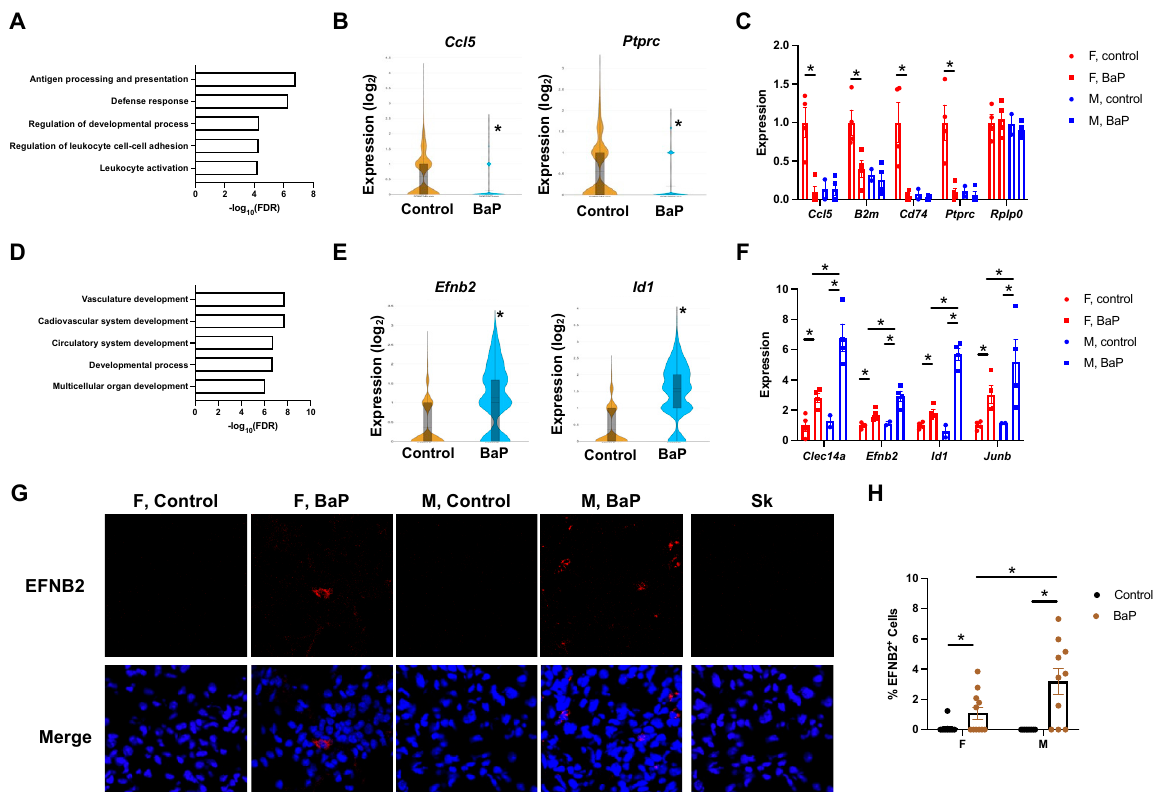
Figure 4. BaP treatment stimulated the expression of vasculature genes in the MRL lung in a male-biased manner. ( A ) Top gene ontology categories enriched in genes downregulated by BaP treatment in female MRL lungs, with example genes shown in ( B ). ( C ) Validation of BaP-downregulated, immune-associated genes by qPCR. ( D ) Top gene ontology categories enriched in genes upregulated by BaP treatment in female MRL lungs, with example genes shown in ( E ). ( F ) Validation of BaP-upregulated, pro-angiogenesis genes by qPCR. ( G ) Immunostaining of EFNB2 in female or male control- or BaP-treated lungs, with staining in skin as a negative control and quantification in ( H ) (20 × ). F, female. M, male. Control, vehicle-treated. BaP, BaP-treated. Sk, skin. * p < 0.05, Student’s t